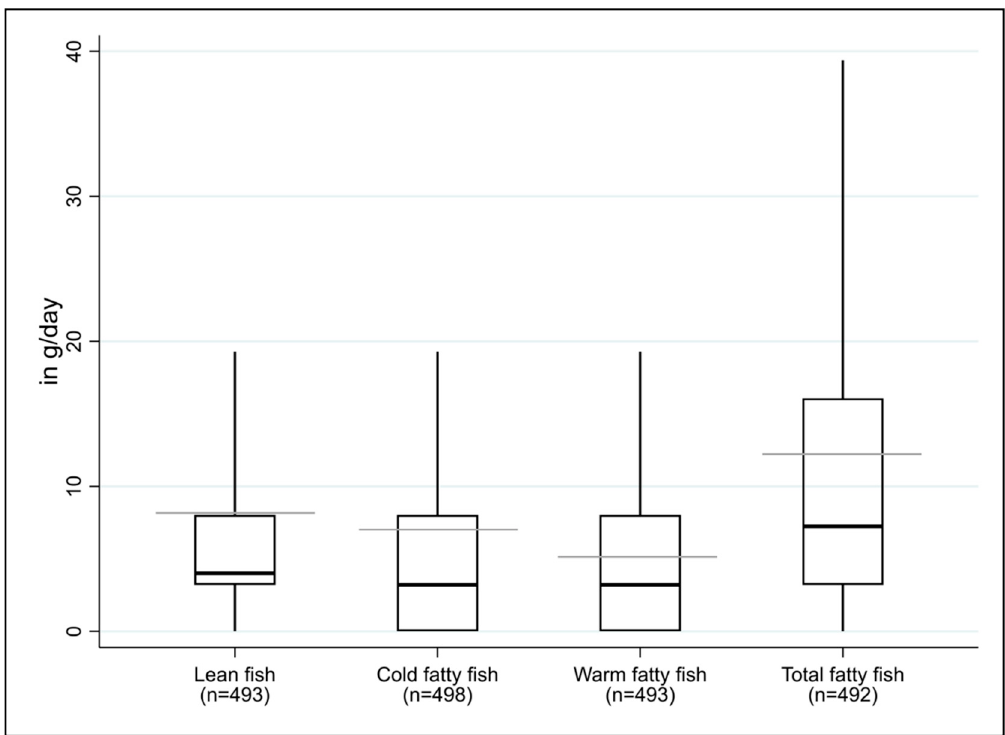
Figure 2. Distribution of baseline consumption of total lean and fatty fish (cold/warm; in g/day) by study participants . Box plot of the distribution of the consumption of lean and warm/cold fatty fish (in g/day) for all participants at baseline. The gray horizontal line shows the arithmetic mean, the bold, black horizontal line inside the box shows the median. The bottom and top of the box are the bottom and top quartiles of the distribution. The length of the black, vertical “whiskers” corresponds to the 5th and 95th percentile of the variable.